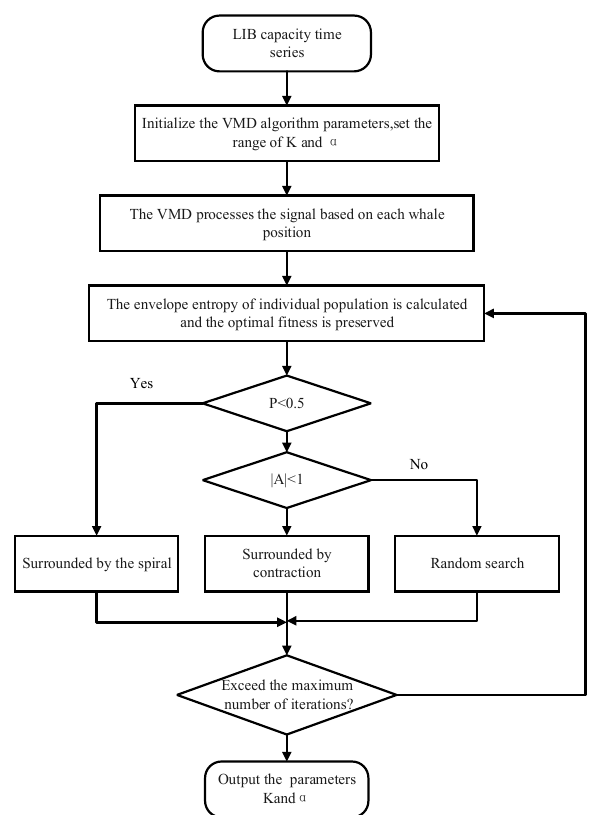
Figure 1. Flowchart of the WOA-VMD method.